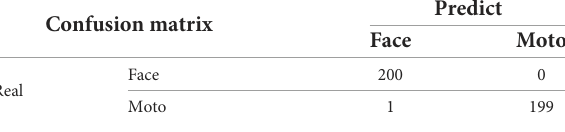
TABLE 4 Confusion matrix of face/motorbike